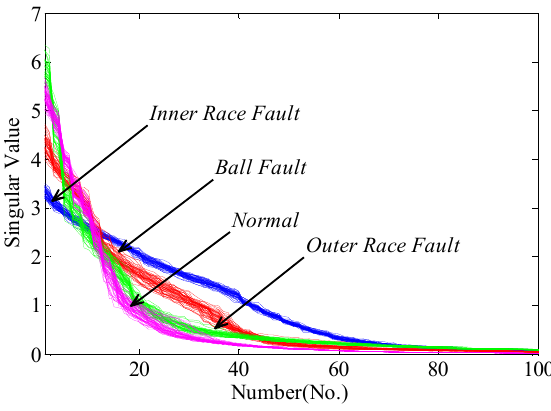
Figure 9. Singular value sequences corresponding to four bearing conditions.